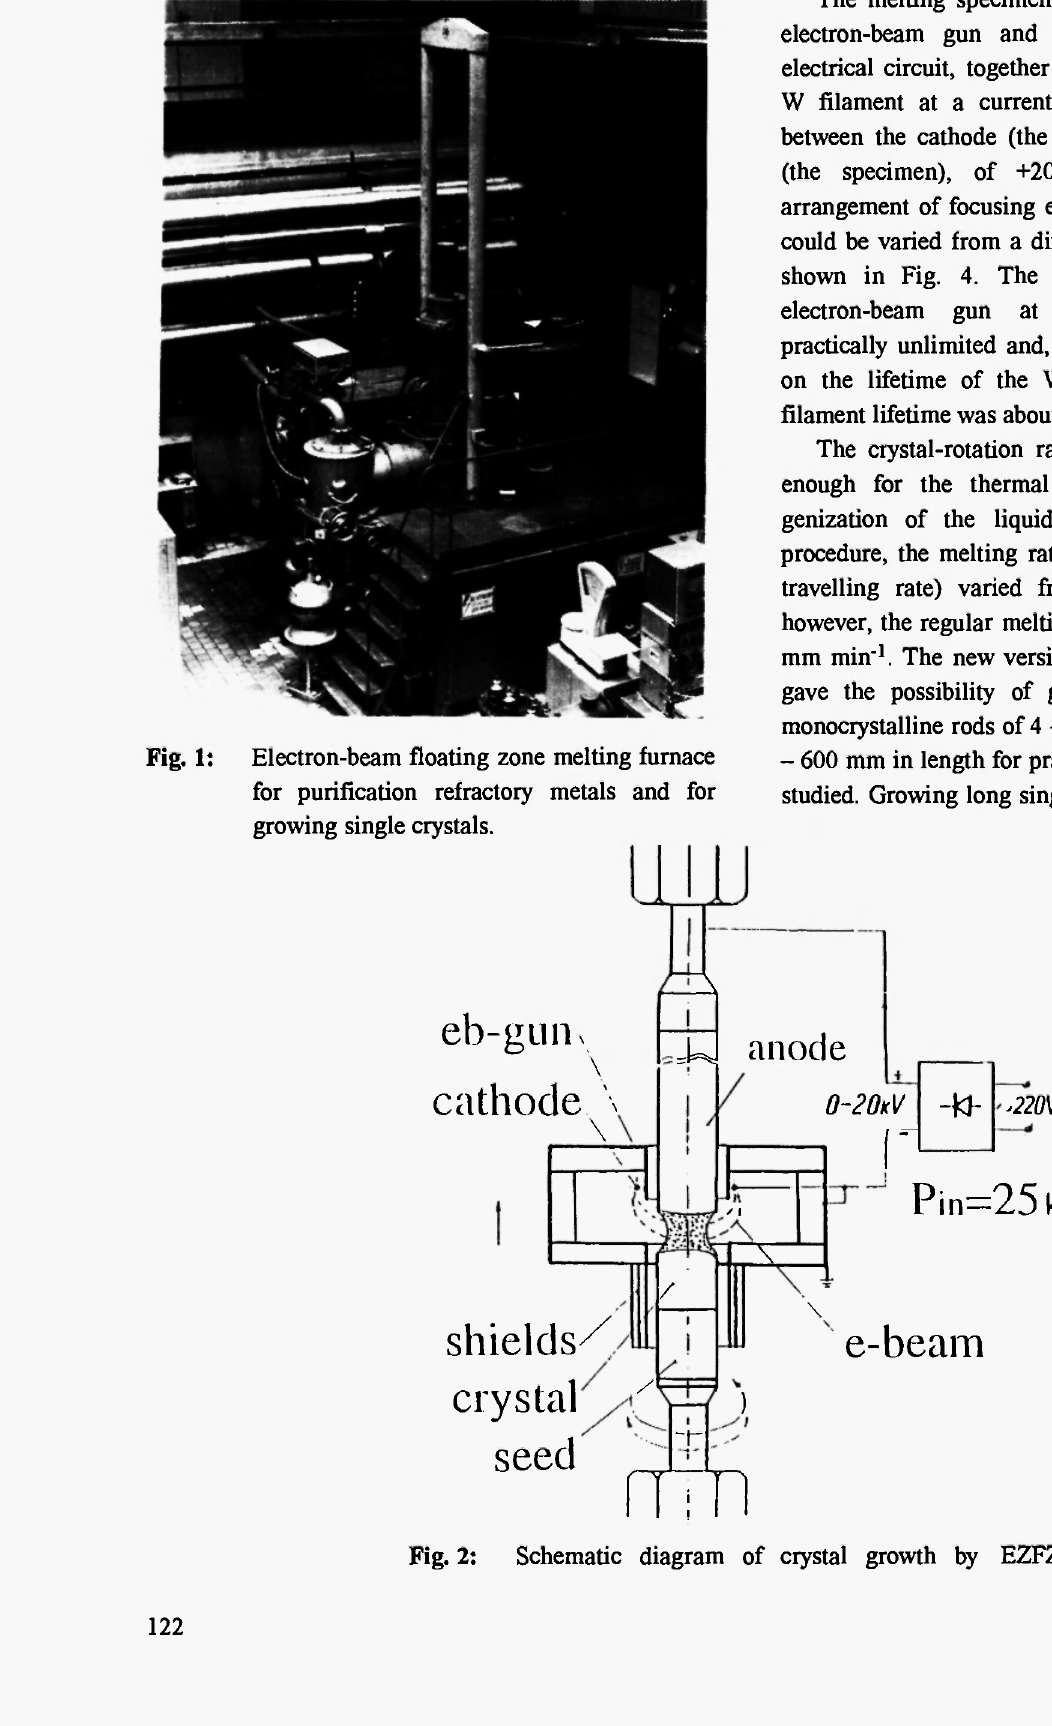
Fig. 2: Schematic diagram of crystal growth by